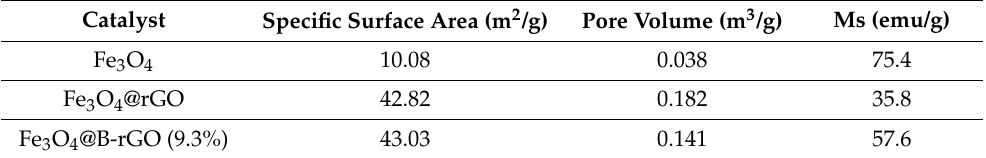
Table 3. The properties of Fe 3 O 4 @B-rGO (9.3%), Fe 3 O 4 @rGO and Fe 3 O 4. Catalyst